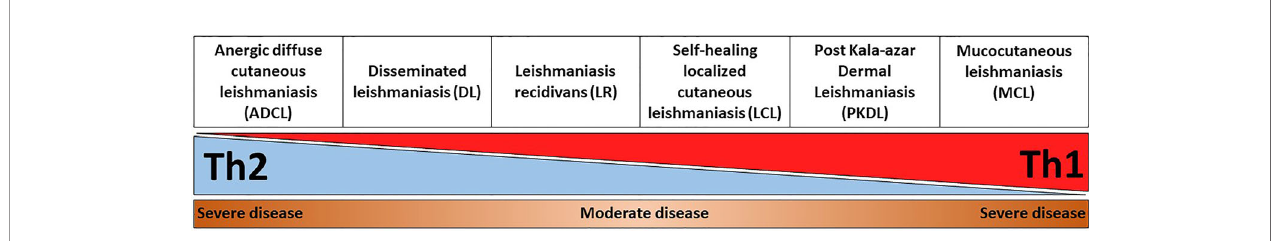
FIGURE 1 | Representation of disease severity and Th1-Th2 balance across different CL and PKDL forms. An exaggerated Th1, or alternatively Th2, response is equally detrimental for leishmaniasis patients as it results in enhanced disease severity. For instance, an uncontrolled Th2 response in anergic diffuse cutaneous leishmaniasis (ADCL) can lead to cell anergy and increased disease pathology. On the other hand, an unrestrained Th1 response in mucocutaneous leishmaniasis (MCL) can cause sustained in fl ammation and tissue